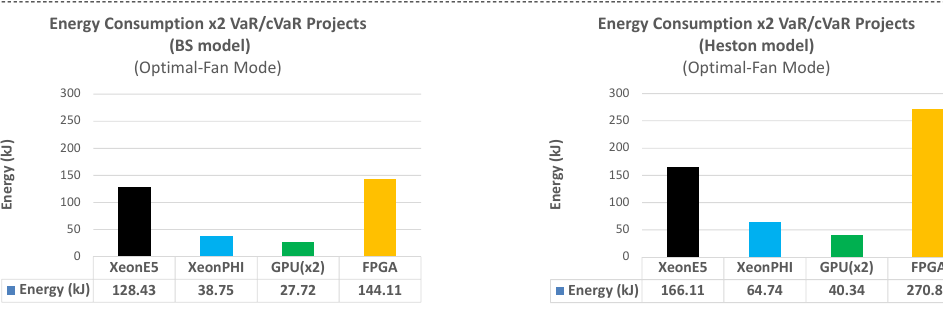
Figure 13. Energy consumption at system-level in the case of × 2 VaR/cVaR projects with the same setup. In this case, each GPU device on the Nvidia K80 card runs its own project (the observed runtime difference compared to the single (x1) project is: BS = ( 0.6s ) ; Heston = ( 2.4s ) ). In the case of CPU, XeonPhi, and FPGA, we need to run one project after the other in a sequential